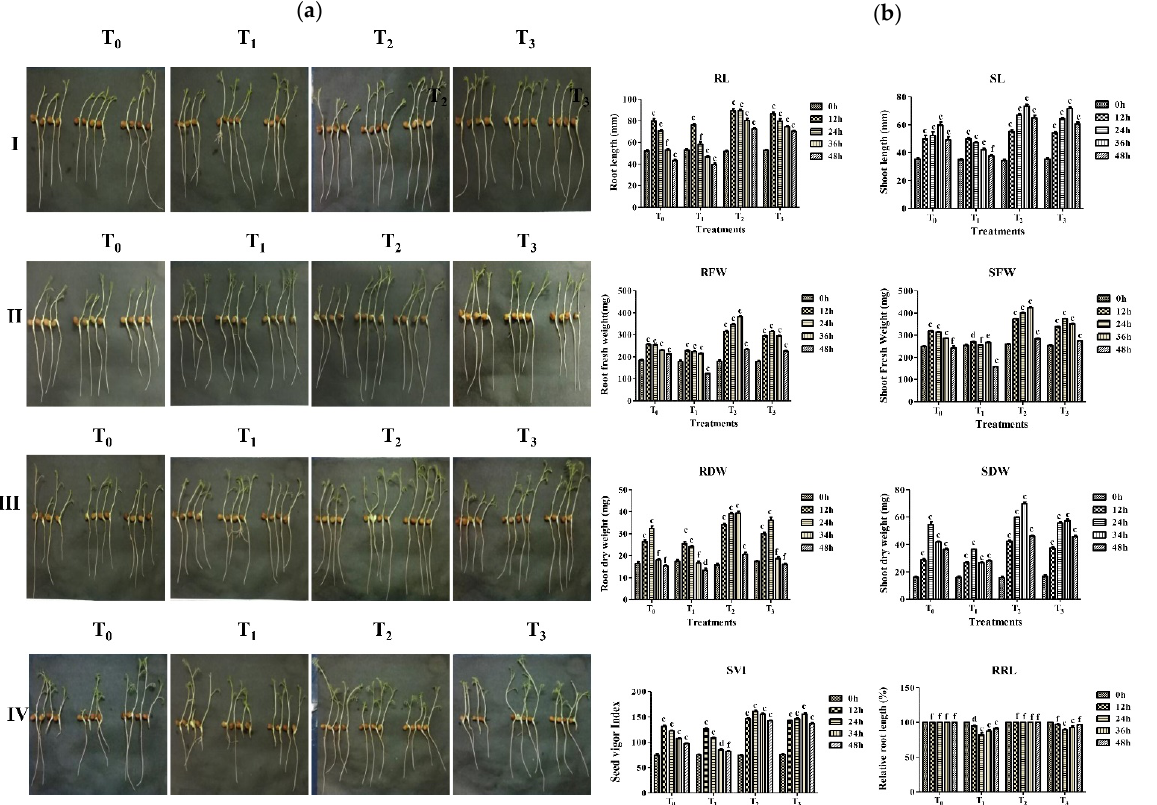
(Table 7). The percentage of disease incidence was 12.12 ± 1.0 to 21.37 ± 1.3%, disease sever- ity was 5.95 ± 0.5 to 10.29 ± 0.8%, and disease reduction was 44.70 ± 5.2 to 67.23 ± 2.3% when both A7 and Foc were inoculated in the soil simultaneously. Interestingly, when the soil was first treated with A7 before two days of the inoculation of Foc , the disease reduction was maximum 66.01 ± 2.9 to 77.00 ± 1.5% and minimum disease incidence 7.4 ± 0.6 to 14.99 ± 0.6 and disease severity 1.85 ± 0.1% to 3.92 ± 0.1% was observed from the plants compared to the soil treated only with Foc . Similarly, when the soil was treated with Foc prior two days to the inoculation of A7, the disease incidence was 13.20 ± 1.0 to 24.56 ± 1.0%, disease severity was 10.48 ± 0.5% to 19.38 ± 0.6%, and the disease reduction was 39.73 ± 1.6 to 62.26 ± 2.5%. From these different combinations of treatments, it was clear that strain A7 showed maximum disease protection when it was applied two days before inoculation of the pathogen and minimum when it was applied two days after the inoculation of the pathogen. From these experimental settings, the plant-growth-promoting activities of strain A7 on chickpea were also observed and recorded. The application of A7 on the plants resulted in the healthy growth of plants compared with the non-inoculated control at the end of 40th days of inoculation. The maximum root length, shoot length and plant biomass was recorded when treated with only A7 compared to control. The PGP parameters including root length, shoot length, root and shoot fresh and dry weight, and the seed vigor index were observed and recorded in different treatments ( p < 0.05) (Figure 6, Table 8).